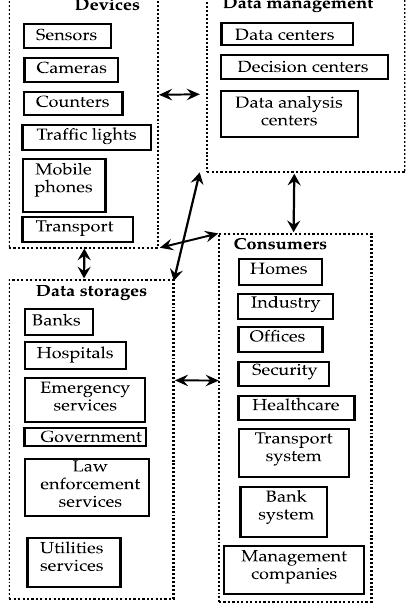
Figure 1. The general model of data transmission.